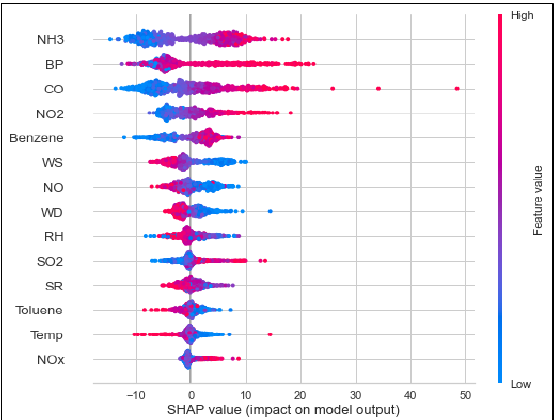
Figure 7. Impact of air pollutants and meteorological parameters on the CB regression model.